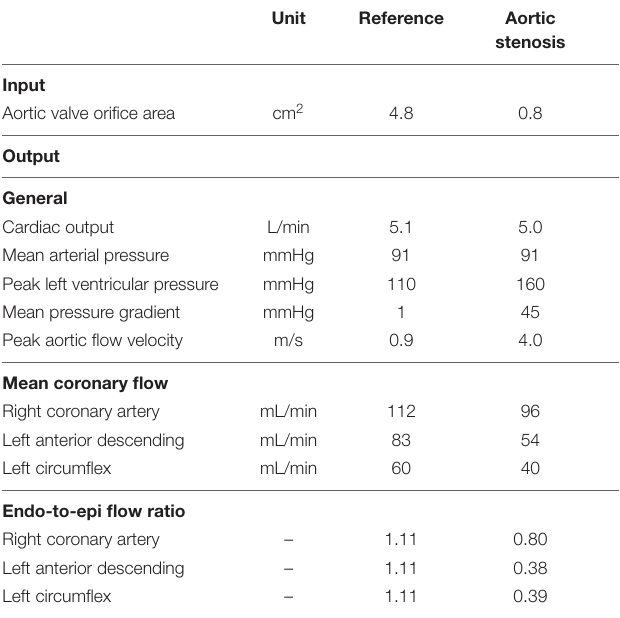
TABLE 4 | Comparison of reference model parameter values with the case of aortic valve